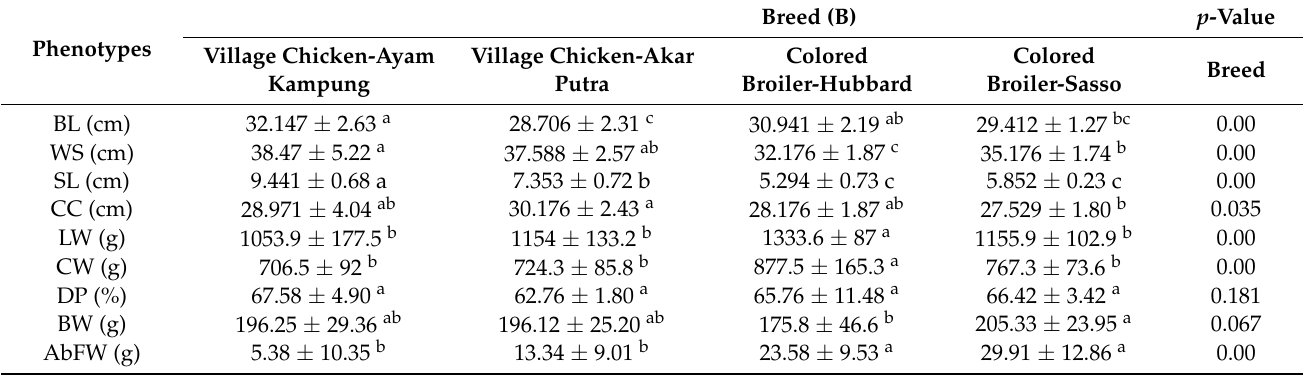
Table 5. Effect of breed on live weight, body size, and carcass characteristics of Malaysian village chickens and two underaged colored broiler